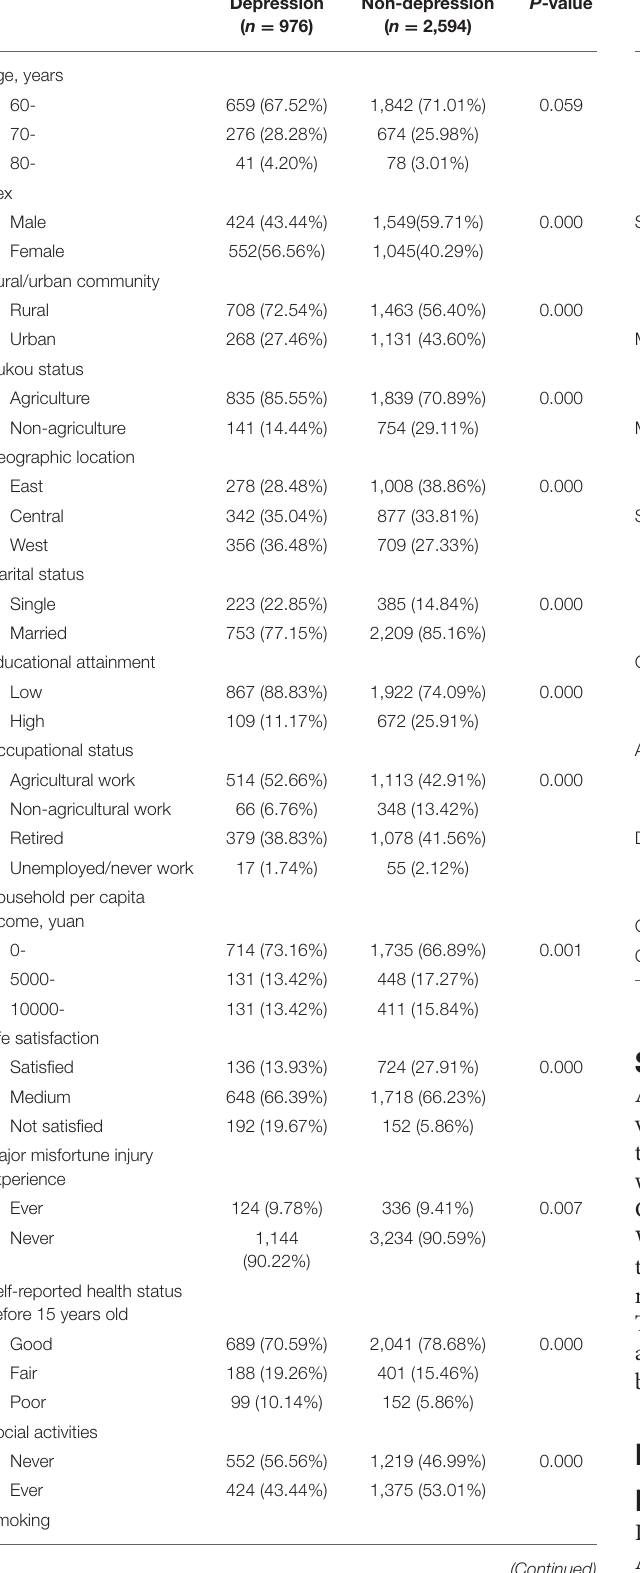
Depression Non-depression ( n = 976) ( n =